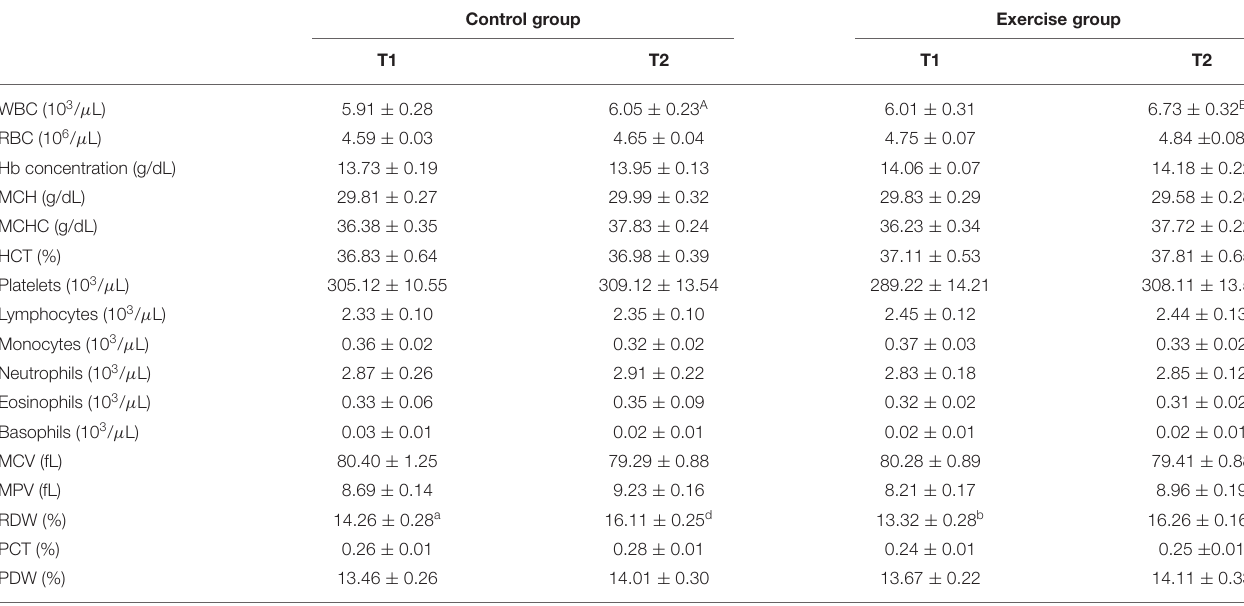
TABLE 4 | Hematological parameters from the control and exercise groups.